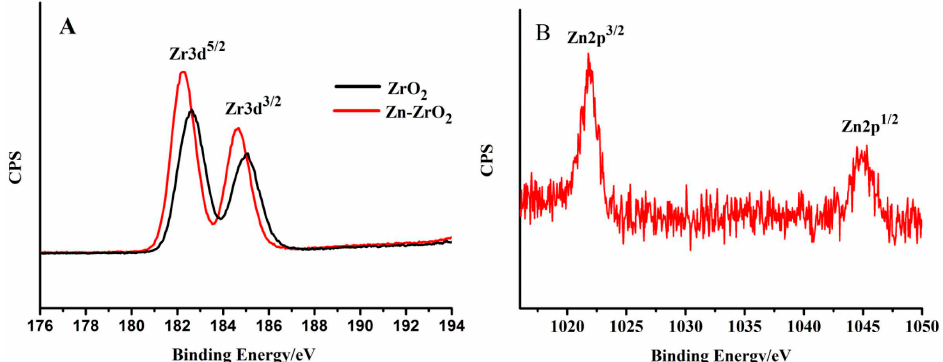
Figure 5. The XPS spectra of ( A ) Zr 3d and ( B ) Zn 2p in the ZrO 2 and Zn–ZrO 2 (1%) NPs.